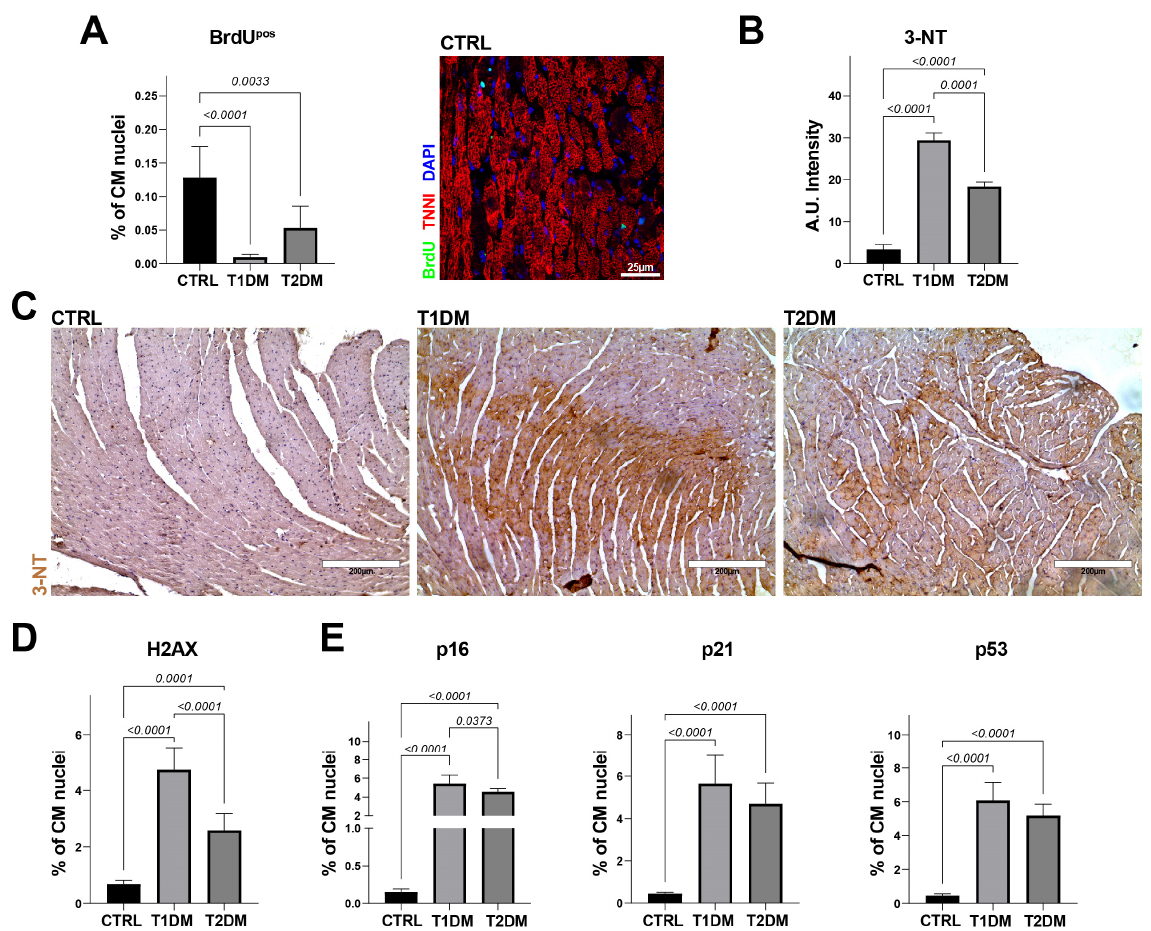
Figure 4. STZ-based T1DM and T2DM mouse models affected myocardial oxidative stress differently. ( A ) Bar graph and representative confocal image showing the percentages of BrdU-positive CMs in CTRL, T1DM and T2DM (CTRL, n = 7; T1DM, n = 8; T2DM, n = 9). Scale bar= 25 µm. ( B ) Bar graph showing quantification of 3-NT intensity levels in T1DM and T2DM cross-sections compared to CTRL tissue sections. ( C ) Representative light microscopy showing 3-NT-positive cardiomyocytes (3-NT, brown) from T1DM, T2DM and CTRL mice (CTRL, n = 7; T1DM, n = 8; T2DM, n = 9). Scale bar = 200 µm. ( D , E ) Bar graphs showing the percentages of γ -H2AX-, p16-, p21- and p53-positive CMs in cardiac cross-sections from CTRL, T1DM and T2DM (CTRL, n = 7; T1DM, n = 8; T2DM, n = 9). Data are mean ± SD.